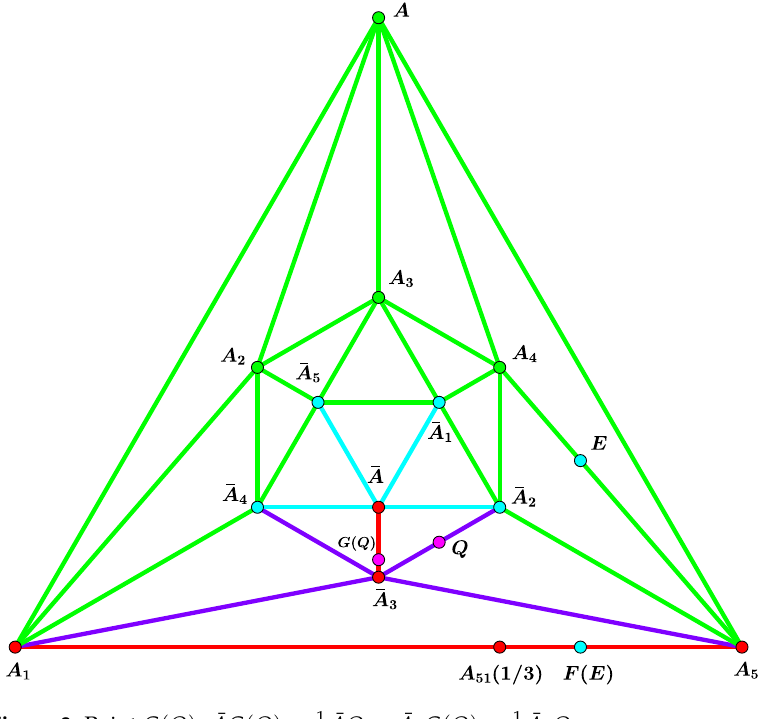
Figure 3. Point G ( Q ) : ¯ AG ( Q ) = 1